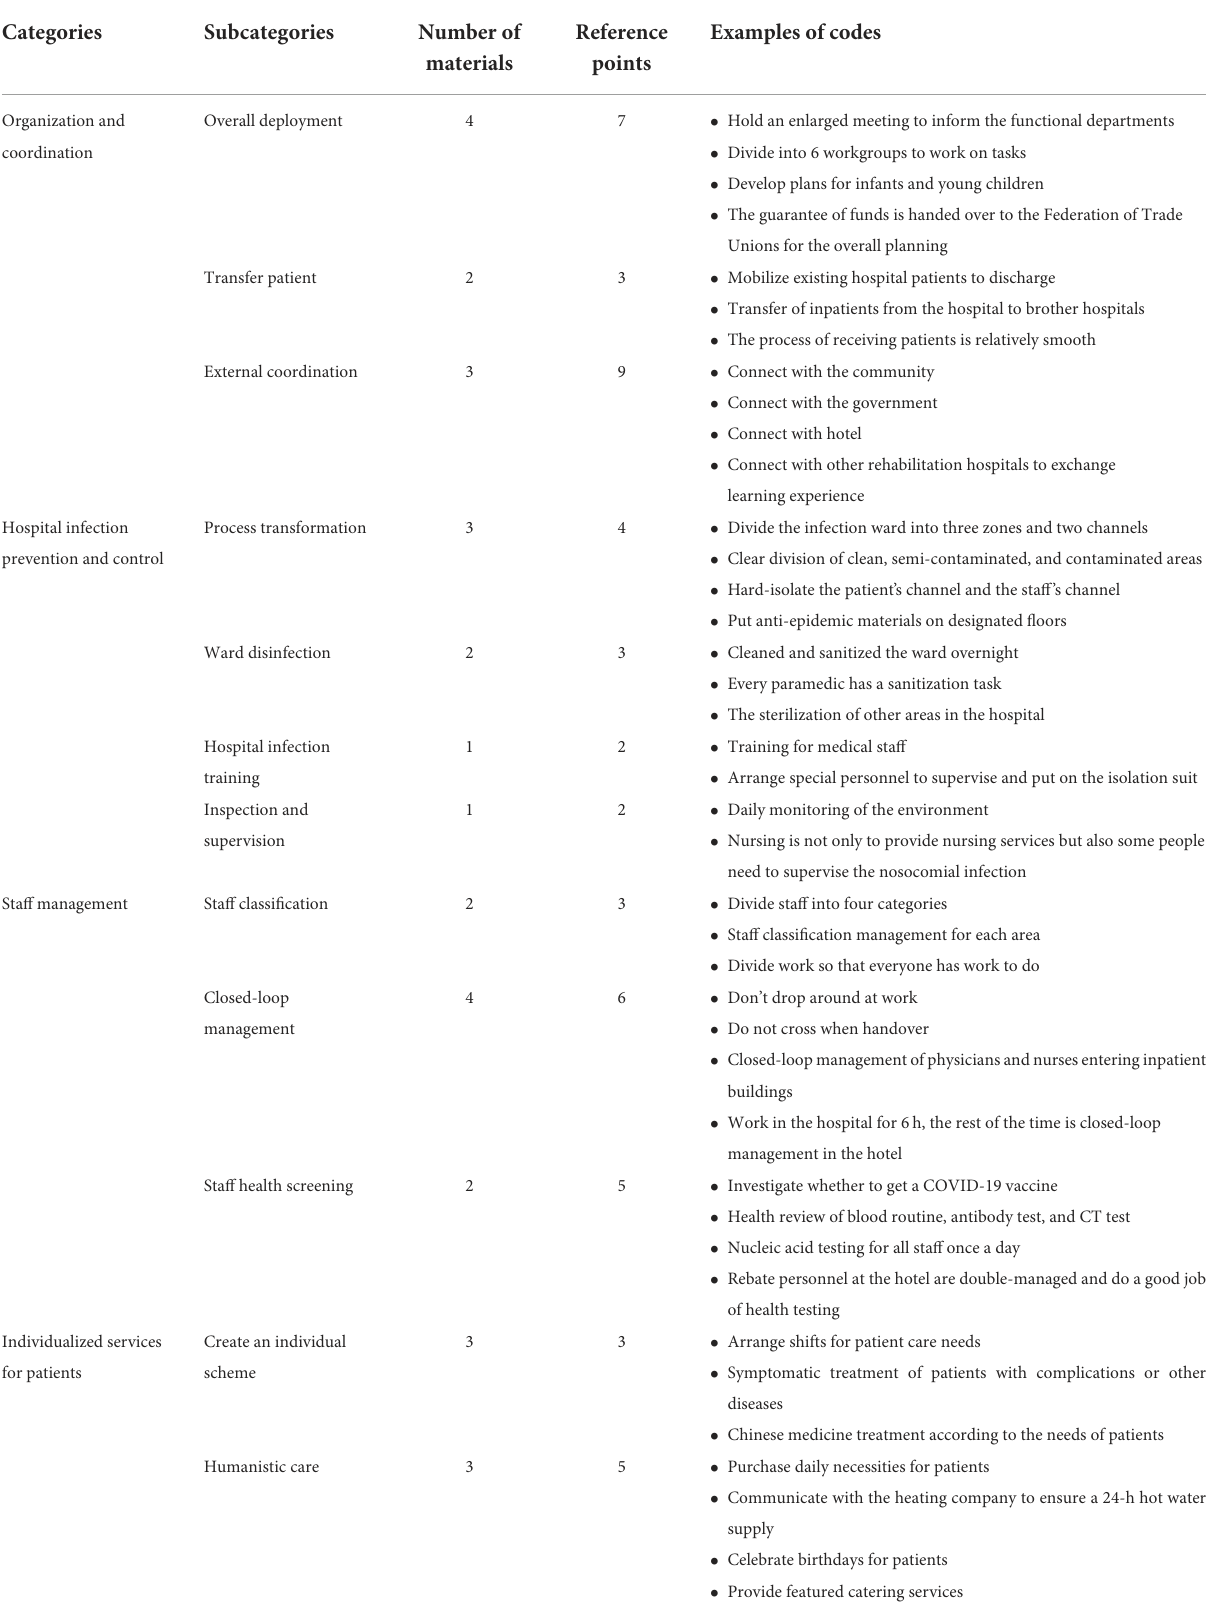
TABLE 2 The rehabilitation works organized by the